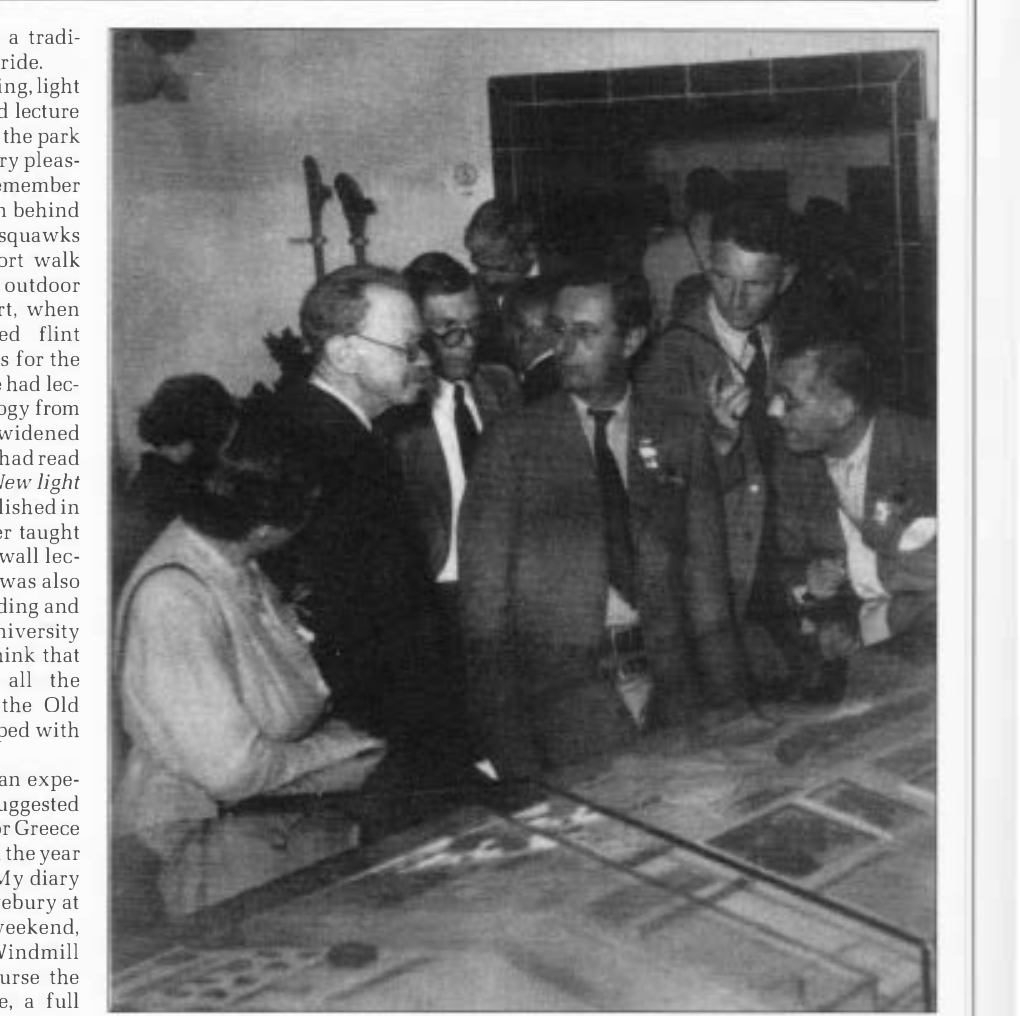
Figure 2 Cordon Childe with fellow prehistorians visiting the museum at Schaffhausen during the third congress of the UISPP in Ziirich, August 1 950:foregroundfrom left